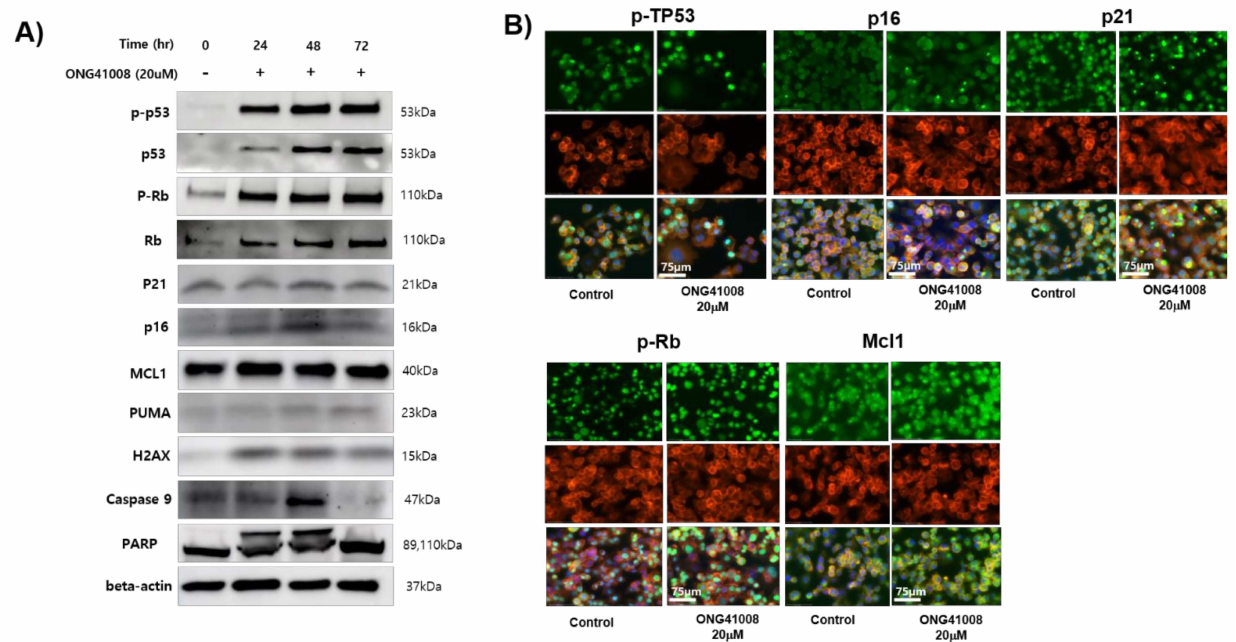
Figure 8. Biochemical and ICC analysis of cancer cell senolytics (CCS) associated with ONG41008. ( A ) PANC1 cells were stimulated with 10 µ M ONG41008 for 6 h. ICC was conducted with antibodies against p-TP53, p21, p16, p-Rb, or Mcl1, giving rise to green cells and further stained with phalloidin (red) and DAPI (blue). ( B ) PANC1 cells were treated with 20 µ M ONG41008 for 48 h. Western